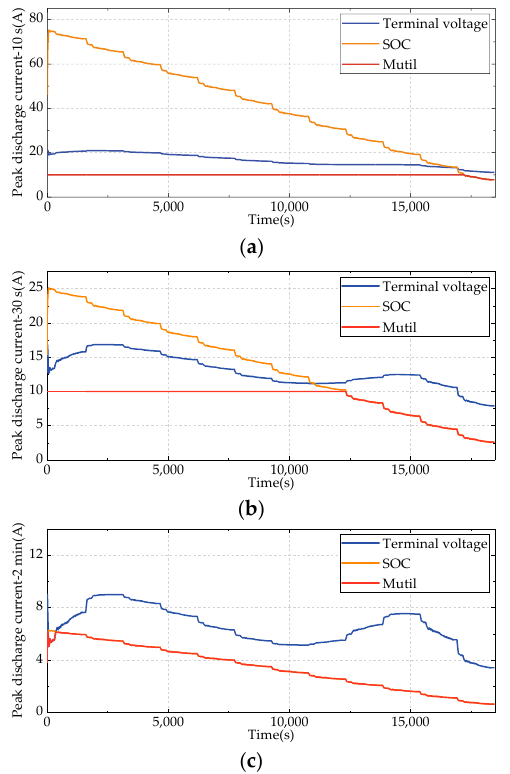
Figure 13. Results of multi-constraint peak discharge current estimation in di ff erent time scales: ( a ) 10 s; ( b ) 30 s; ( c ) 2 min.